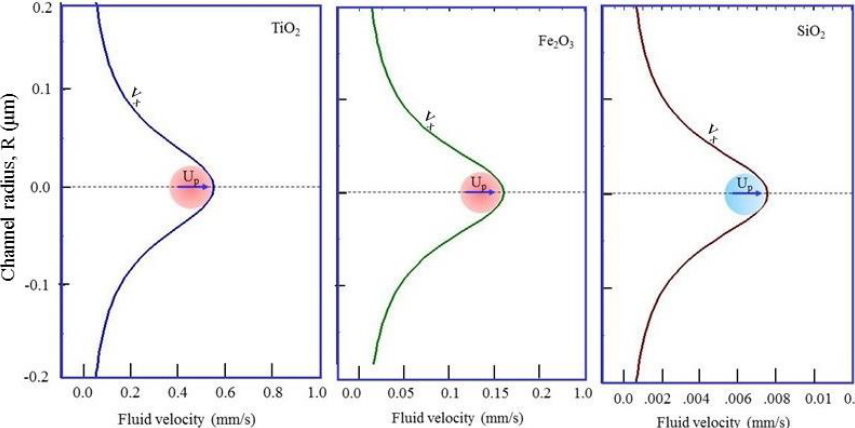
Figure 4. Velocity profiles in axial plane of the flow of water induced by the moving particle ( P o = 4 W, focal length = 75 mm, beam diameter d = 6 mm, λ = 532 nm, nm ( w o = 4.2375 μm, Equation (8)), refractive index of water n f = 1.332, water viscosity μ f = 0.98 × 10 −3 kg/m-s, a = 50 nm, the particle is at the beam waist).